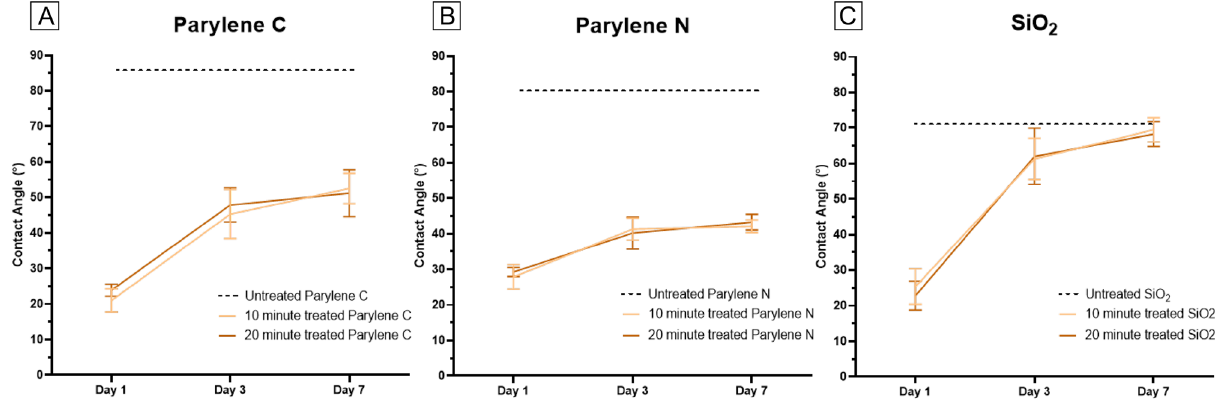
Figure 7. Contact angle measurements from day 1, day 3, and day 7 of plasma treatment for ( A ) Parylene C, ( B ) Parylene N, and ( C ) SiO 2 surfaces. The dashed line in each plot represents the measurements from the respective untreated